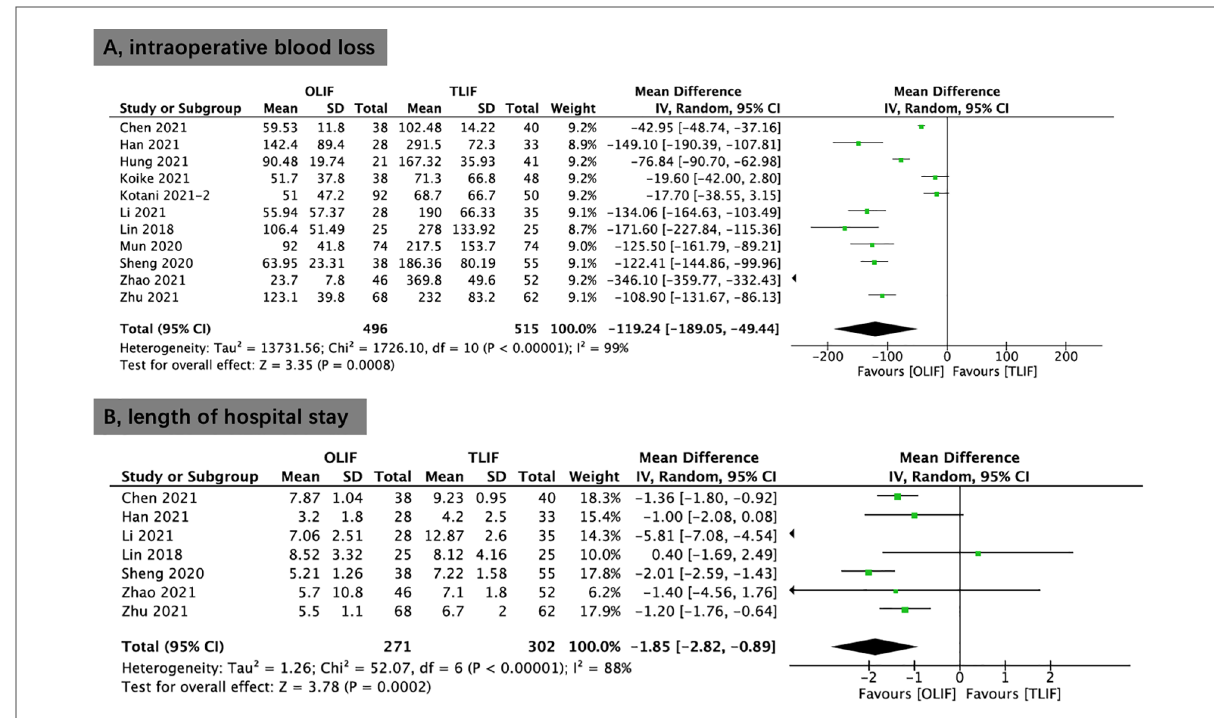
FIGURE 8 Forest plots comparing intraoperative blood loss ( A ) and length of hospital stay ( B ) between OLIF and TLIF. OLIF, oblique lumbar interbody fusion; TLIF, transforaminal lumbar interbody